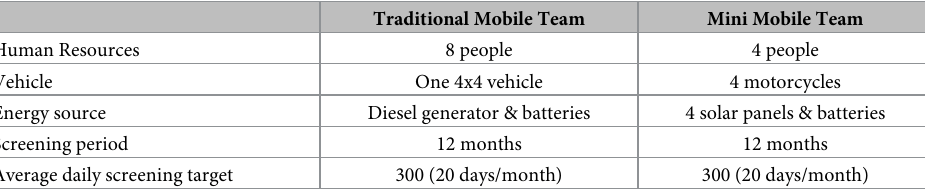
Table 1. Organisational